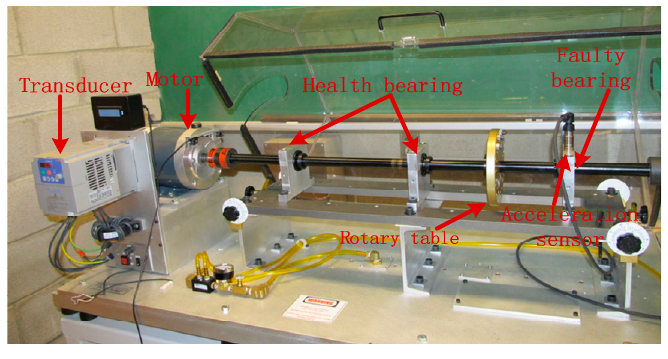
Figure 8. The test rig.